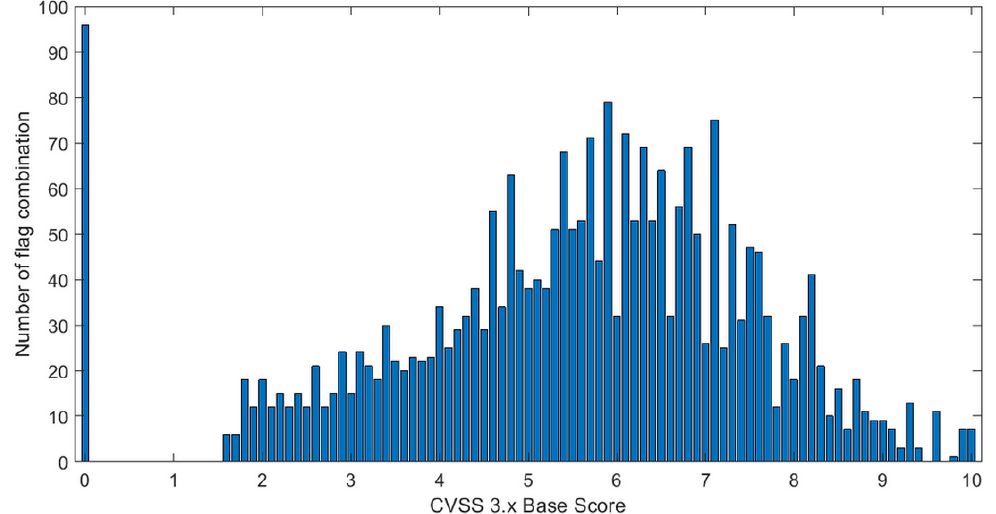
Figure 3. Number of combinations (scenarios) corresponding to the baseline scores.